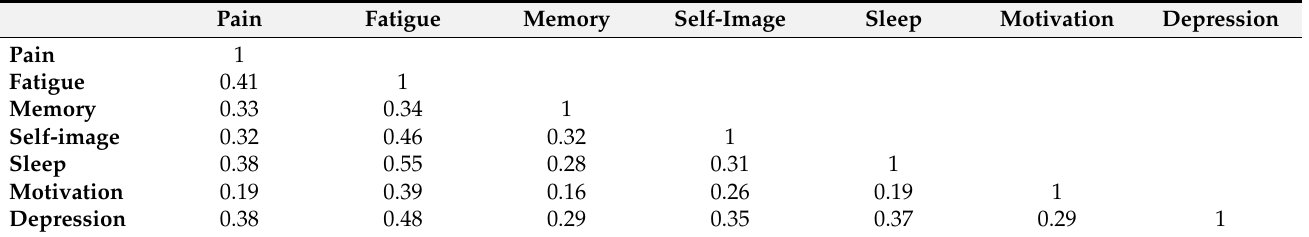
Table 4. Item-to-item polychoric correlations between the dimensions of the PB-HIV Index.